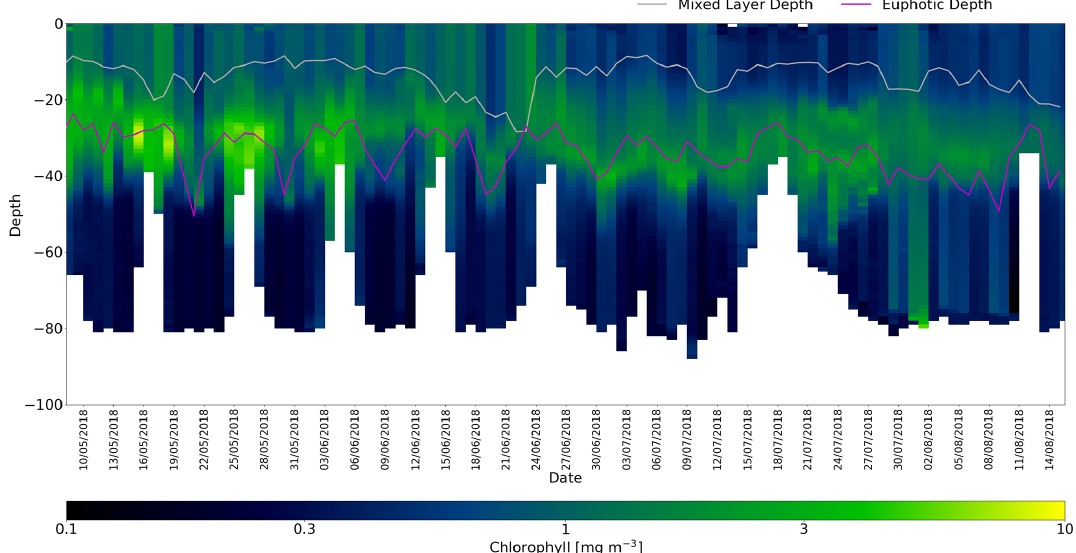
Figure 7. Quenching-corrected [Chl- a ] time series for 454 (Cabot). The Xing et al. (2012) quenching correction is applied. Mixed layer depth and euphotic depths are as in Fig.